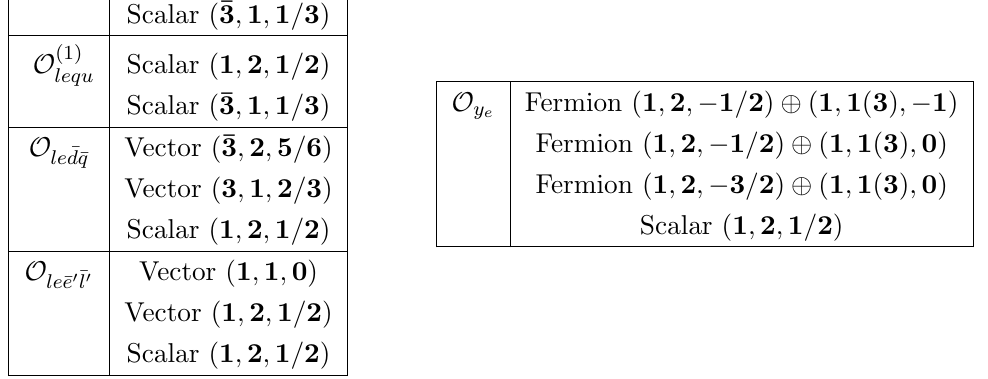
c (cid:2) SU(2) L (cid:2) U(1) Y contributing at the